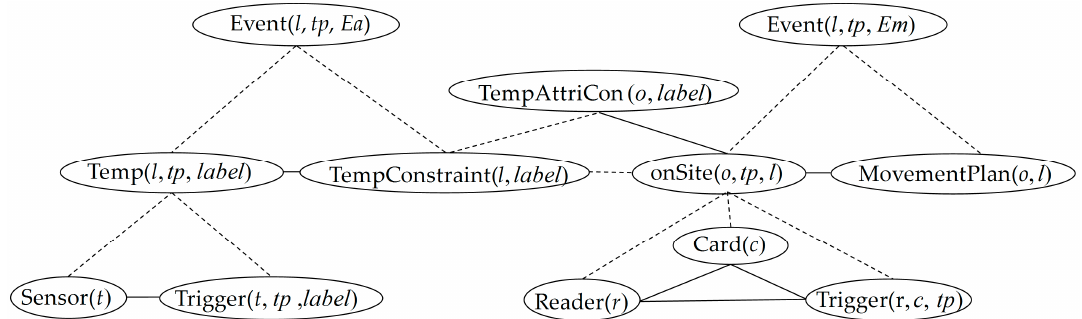
Figure 3. A part of the information fusion model referring to formulas #1, #3, #4, #6 and #8–#10 in Table 2. Table 2. A Part of the knowledge base for event recognition in the scenario of logistic storage in FOL.